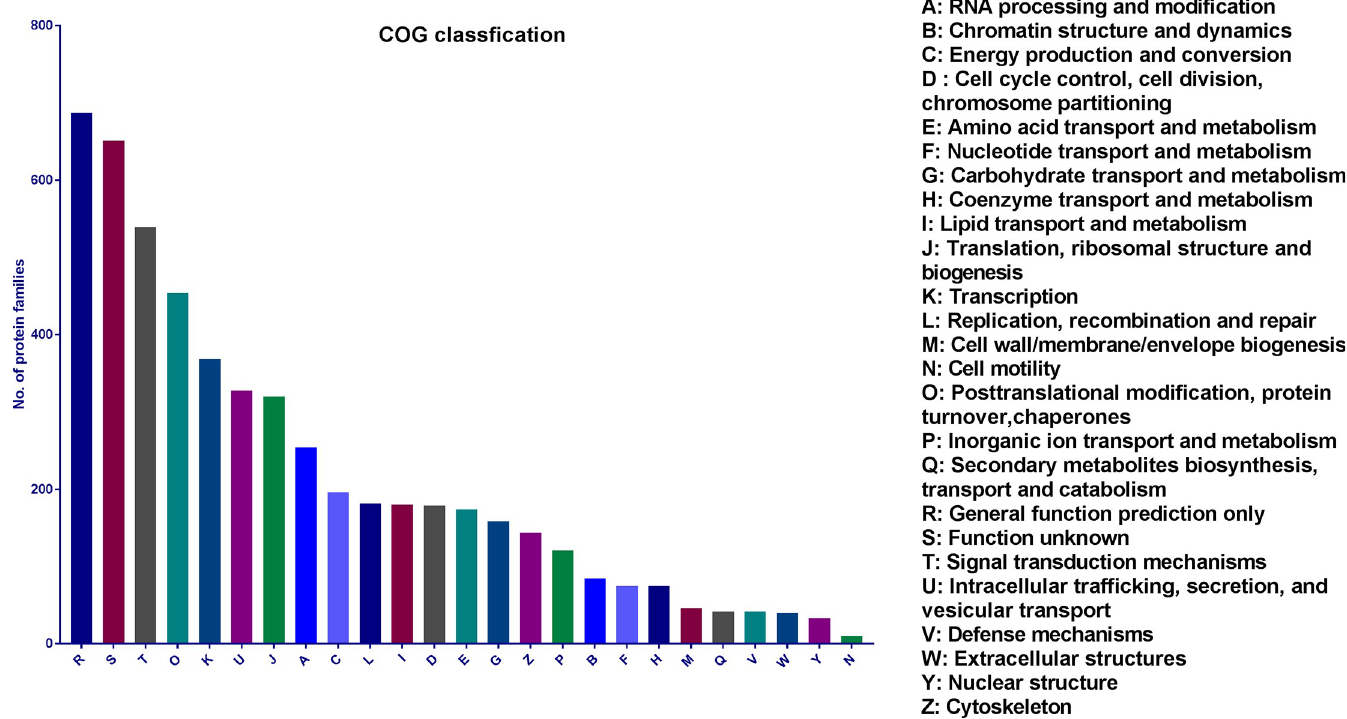
Fig 4. Functional classification of the C . lyallii transcriptome. The identified unigenes were further grouped into 25 categories based on the homology search against the COG database.